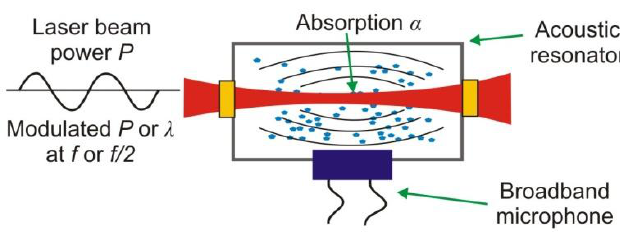
Figure 14. Idea of photoacoustic